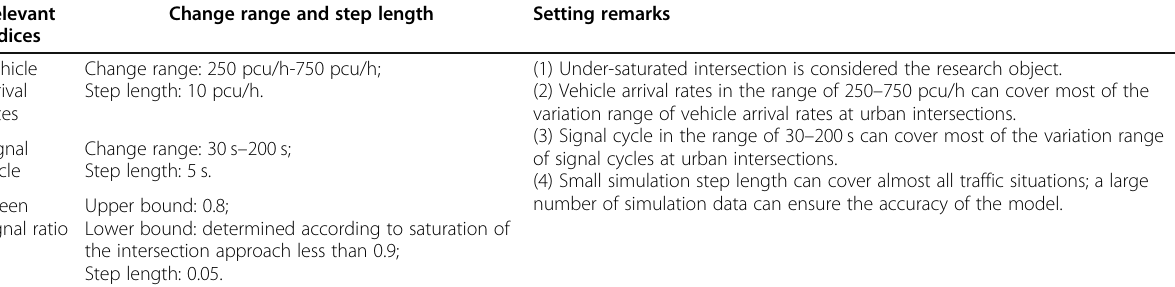
Table 5 Simulation conditions in the process of data